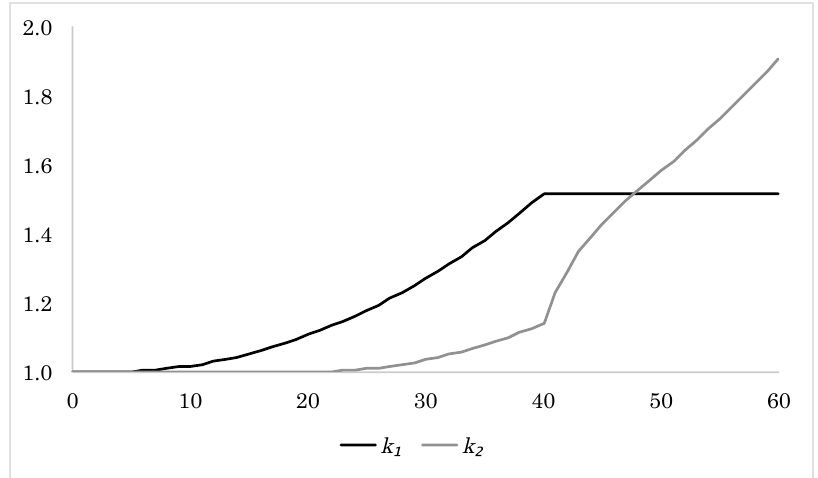
Figure 5. Approximated expected upscaling factors k